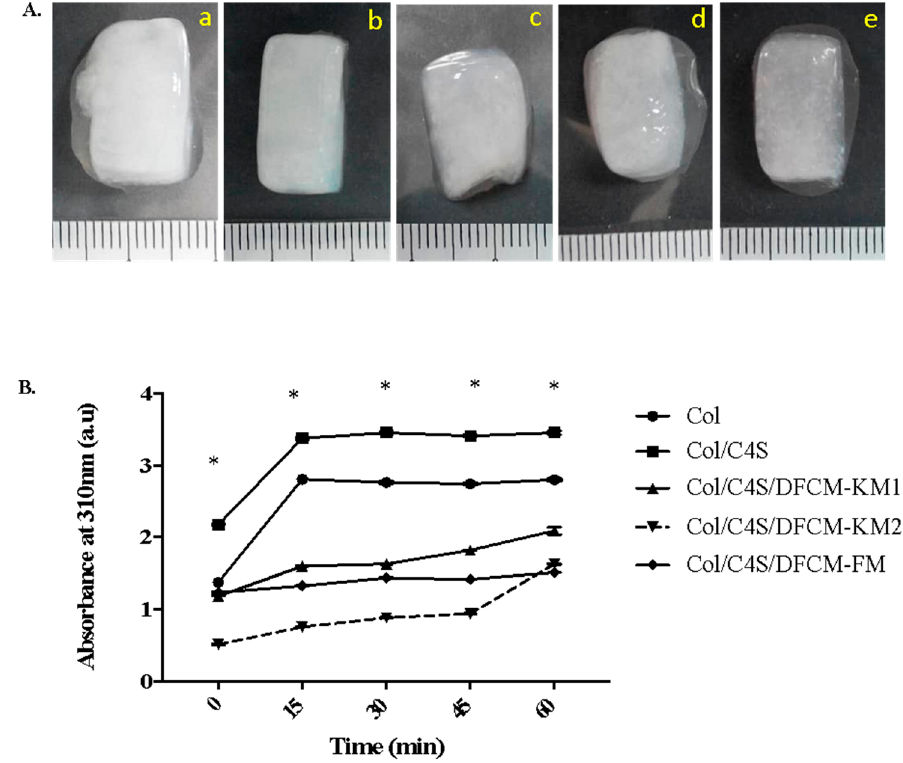
Figure 1. ( A ) The morphology of the polymerized constructs (a: Col; b: Col/C4S; c: Col/C4S/DFCM-KM1; d: Col/C4S/DFCM-KM2; e: Col/C4S/DFCM-FM). The constructs were soft, semi-solid and translucent, and more turbid when mixed with C4S. ( B ) Construct turbidity. Col/C4S construct became slightly cloudy and more turbid, and significantly more so compared to the other constructs (* significantly compared to other groups ( p < 0.001)).